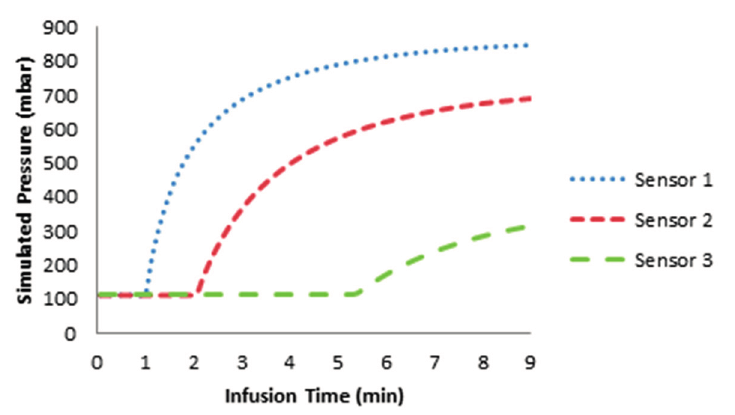
Figure 10. Simulation of the pressure based on Darcy’s